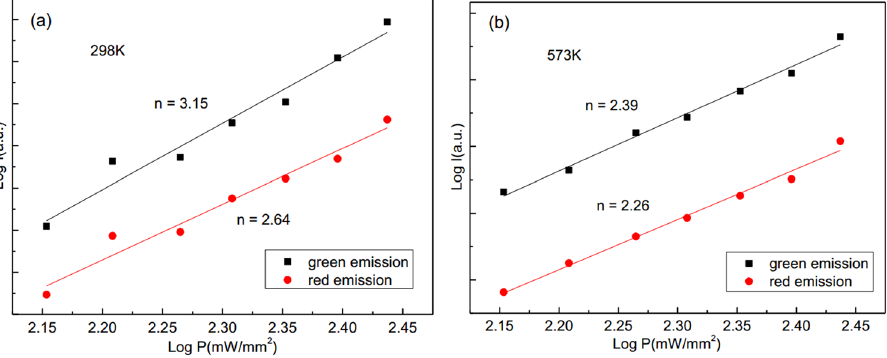
Figure 7. Log-log plots of emission intensity and pumping power for Y 2 O 3 :1%Er 3 + at ( a ) 298 K and ( b ) 573